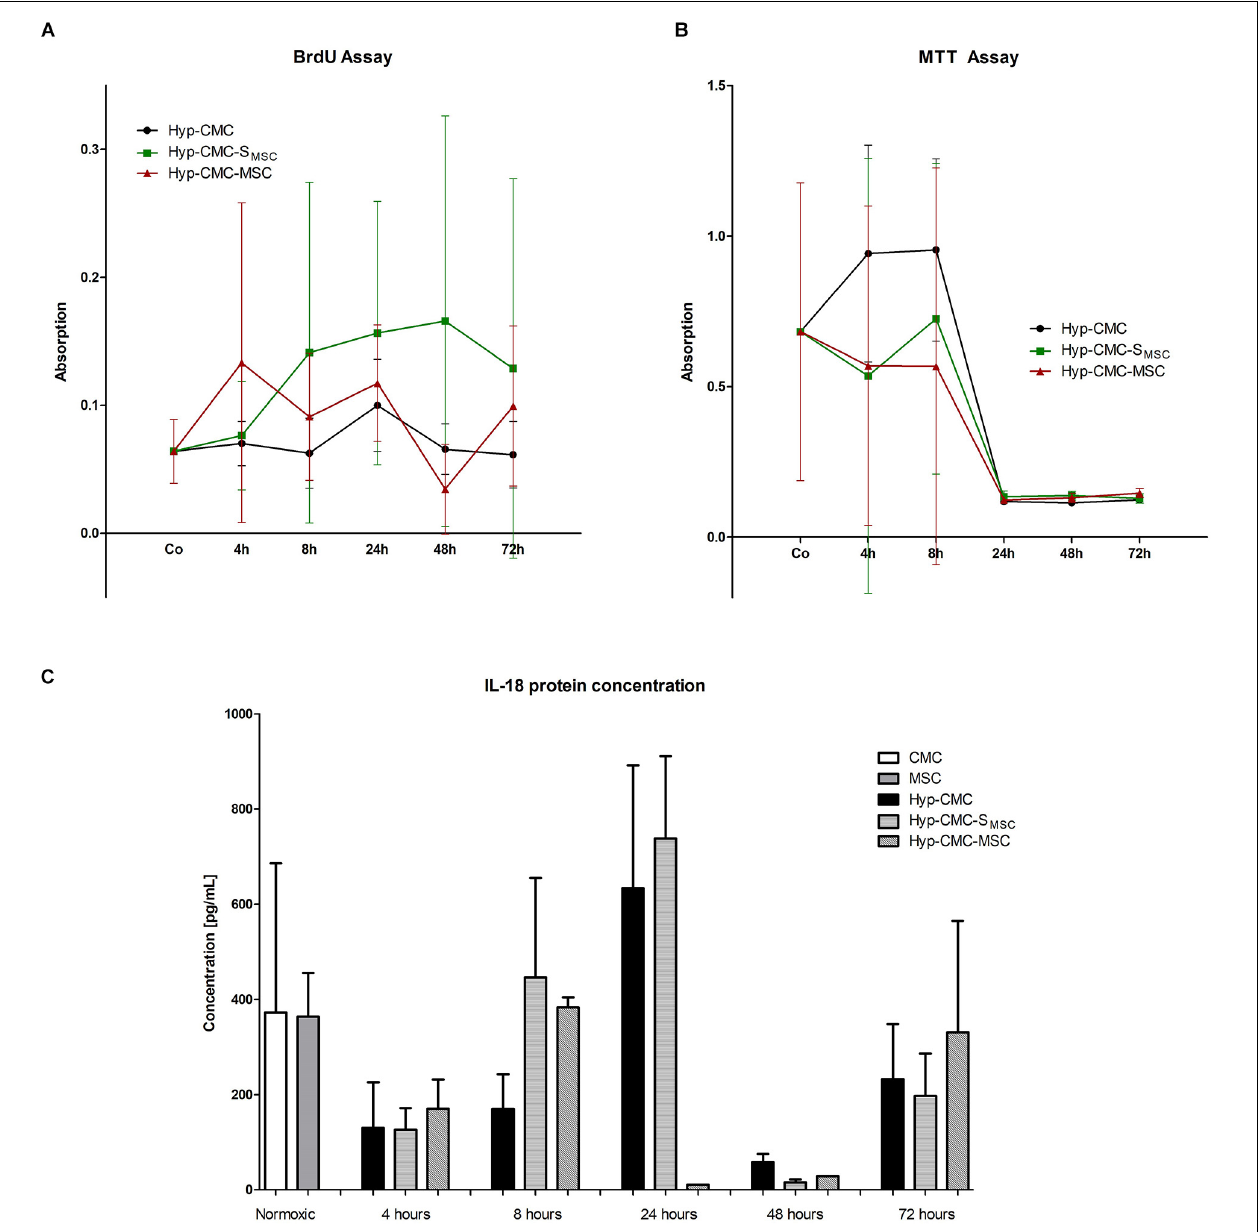
FIGURE 4 | (A–C) BrdU and MTT assay, IL-18 protein concentration analysis with ELISA of the three experimental groups: unstimulated hypoxic CMC (group Hyp-CMC), CMC stimulated with MSC secretome (group Hyp-CMC-S MSC ) and CMC stimulated directly with MSC (group Hyp-CMC-MSC) after the respective reoxygenation period of 4, 8, 24, 48, and 72 h. IL-18 protein concentration of CMC and MSC were also evaluated as control. Each stimulation method and respective time point was analyzed with one-way ANOVA (Kruskal-Wallis test) and groups were compared with the Dunn’s Multiple Comparison Test. * p < 0.05, ** p < 0.01, n = 2 technical replicates (Il-18), n = 6 technical replicates (BrdU and MTT). MSC – Mesenchymal stem cells. CMC – cardiomyocytes. Hyp –